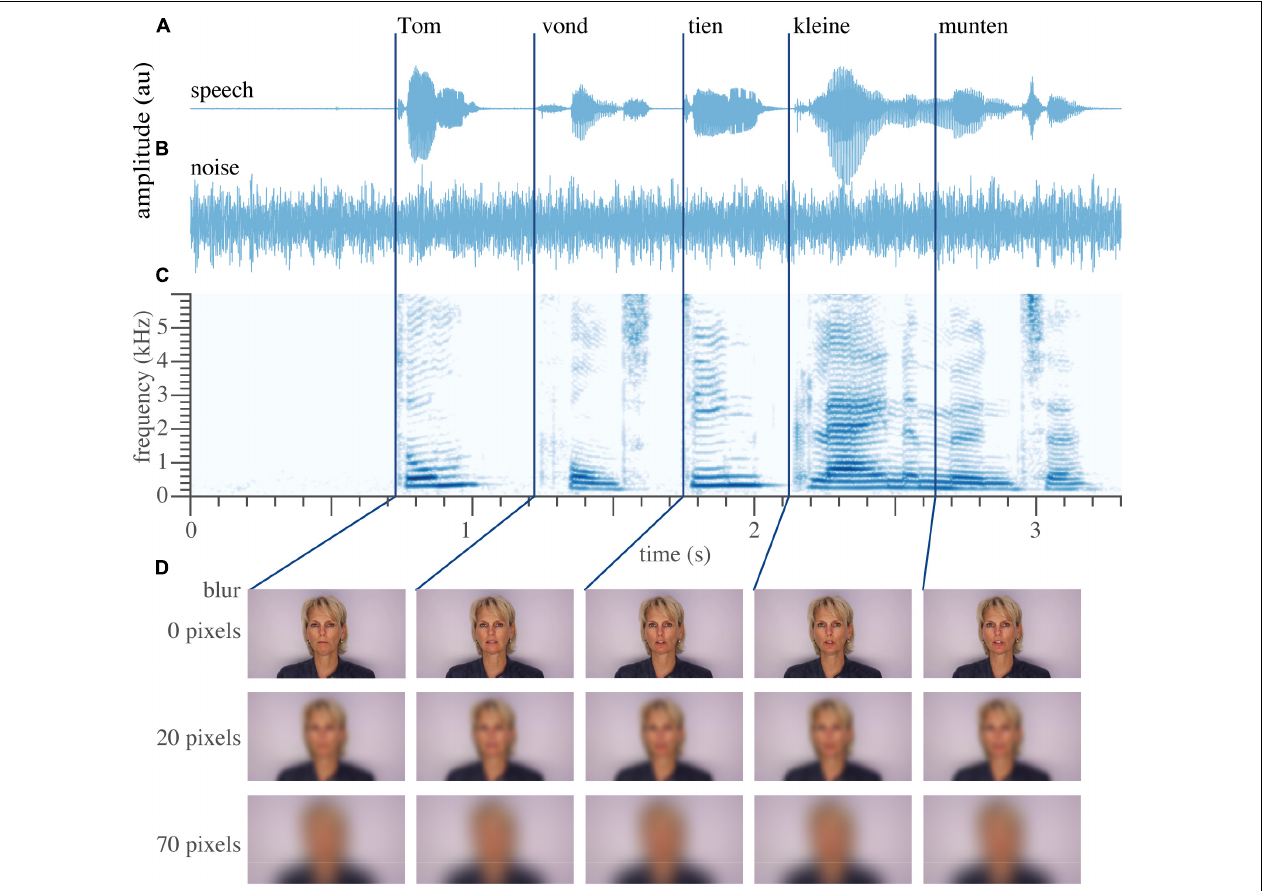
FIGURE 1 | Example sentence. (A) Temporal waveform of the auditory speech signal “Tom vond tien kleine munten” (translation: Tom found 10 little coins.) (B) Waveform of the auditory noise. (C) Spectrogram of the recorded sentence. (D) Five video frames around the onset of the word, untouched (top), moderately blurred (middle, 20 pixels), and extensively blurred (bottom, 70 pixels, used as a unisensory auditory condition in the divided-attention task). Dark blue lines denote the approximate onset of each individual word. Written informed consent for the publication of this image was obtained from the individual shown.